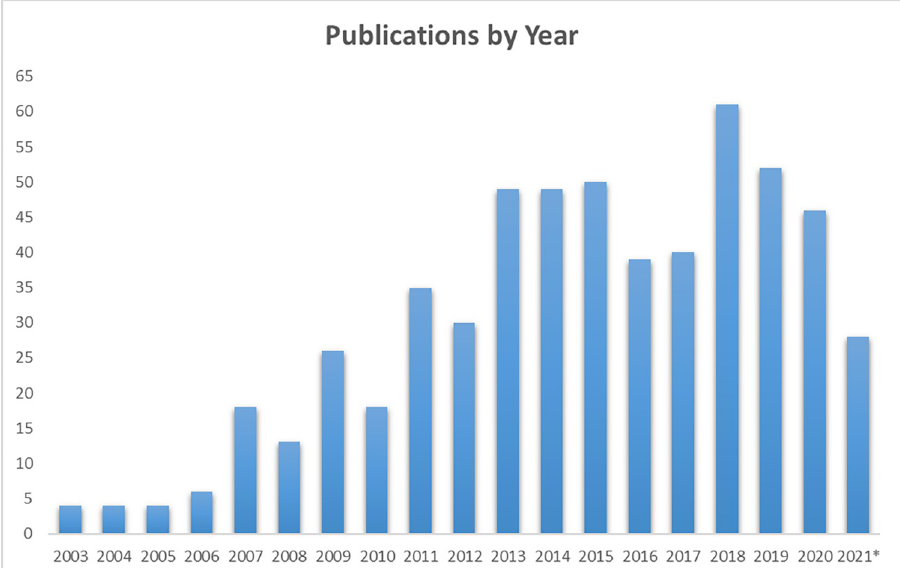
Fig 2. Publications by year that used allostasis terminology in animals. A total of 572 articles were identified in the non-human animal literature using terms related to allostasis and/or allostatic load. � Search results for 2021 are through June and only represent half of the publications from this year.